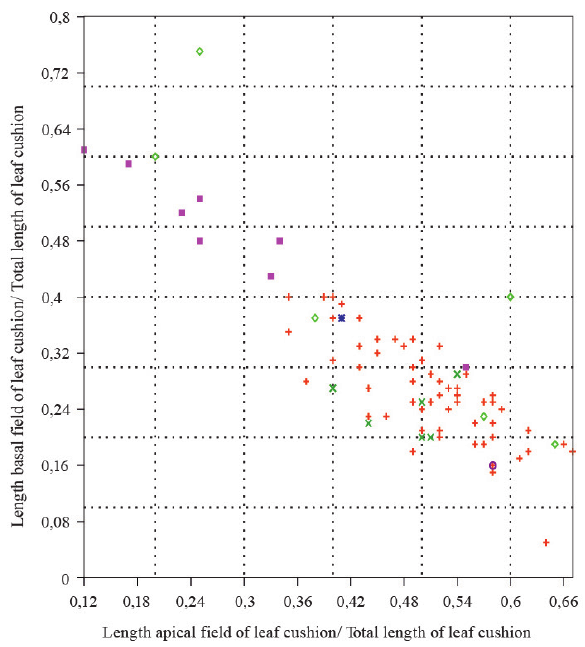
Figure 3. Diagram of the relative dominance of the basal over the apical leaf cushion field. Legend: Hori- zontal axis: Length apical leaf cushion field/ total length leaf cushion, vertical axis length basal leaf cushion field/ total length leaf cushion. Pink square: Lubná red cross: Mt Pelé, light green diamond: Ronchamp, dark green cross: Oelsnitz, dark blue star: St Etienne, purper circle: